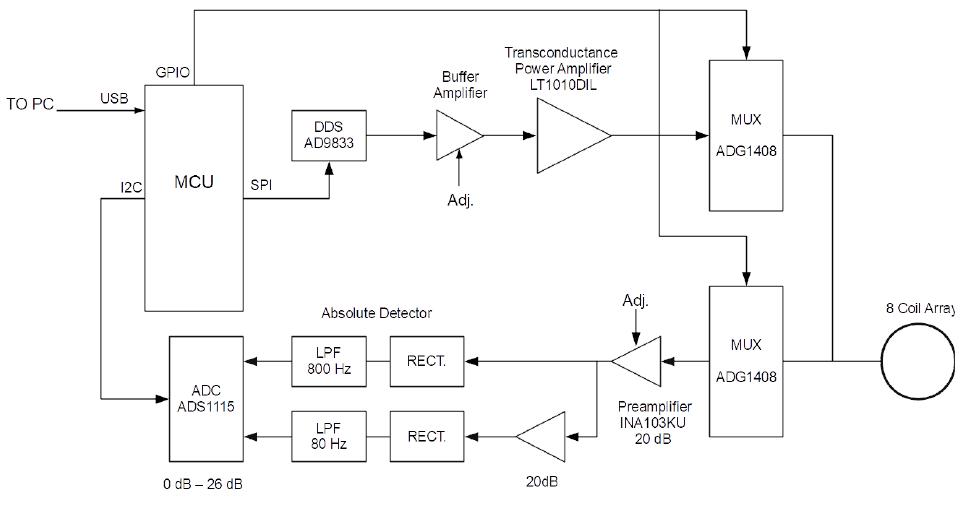
Figure 4. System diagram of the MIT